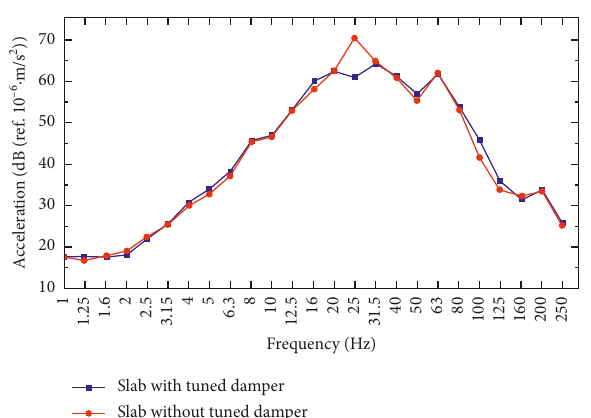
Figure 13: 1/3 frequency path spectrum of track foundation (hammered at fastener).